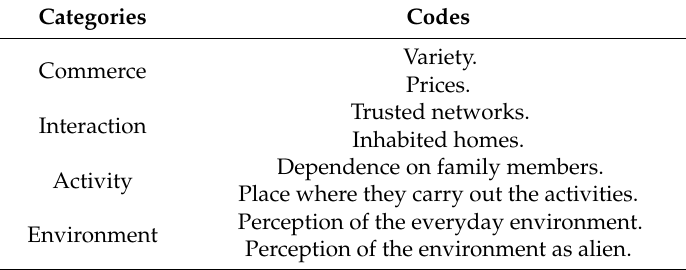
Table 2. Main categories and research